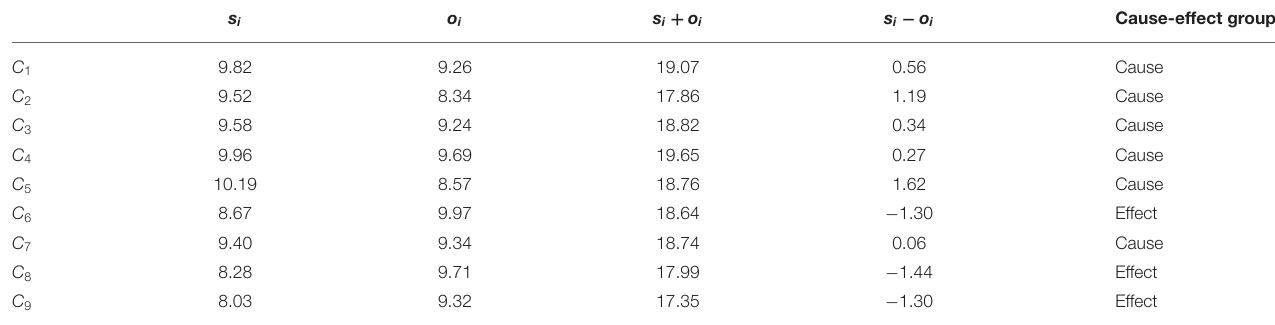
TABLE 5 | The four influence indices.